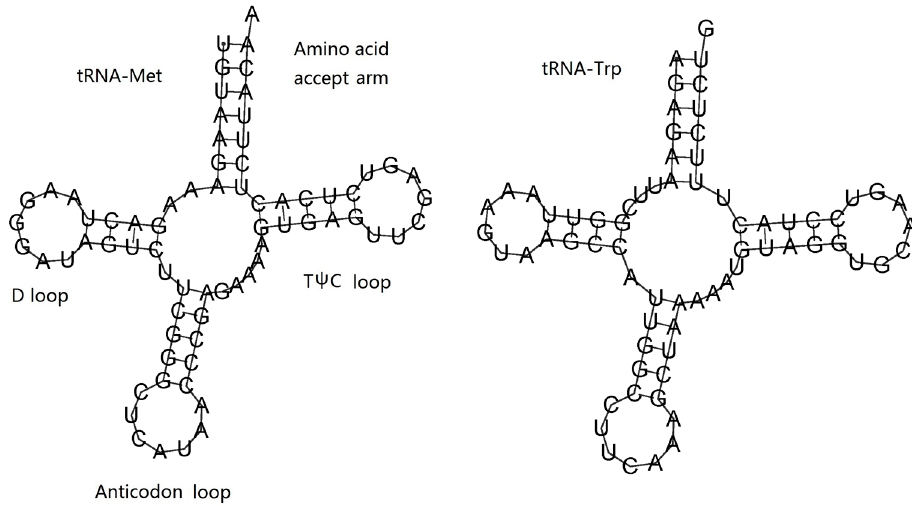
Figure 6. Putative secondary structures of two tRNAs of H. bowerbanki .